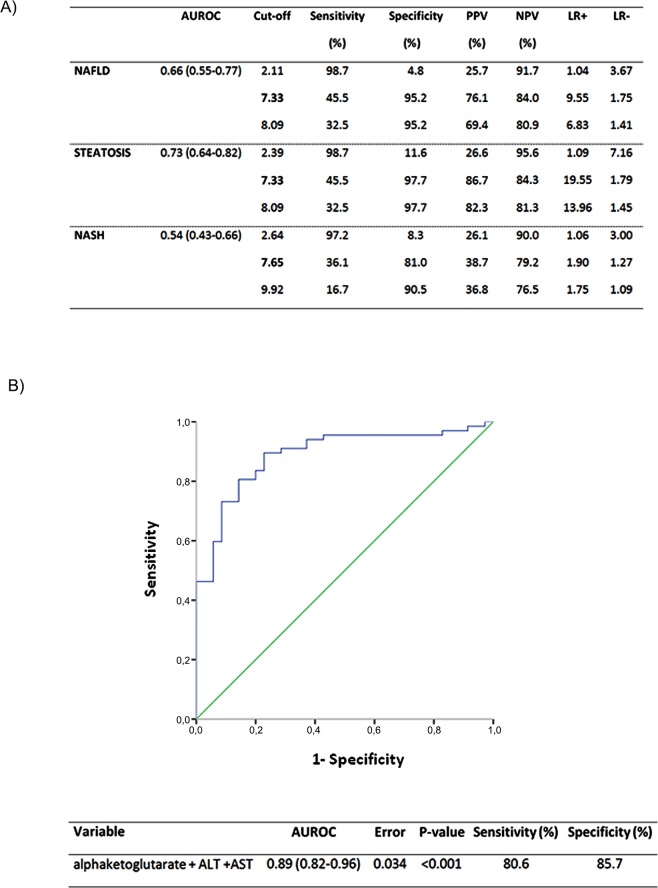
Serum alpha-ketoglutarate as a biomarker.(A) Accuracy of alpha-ketoglutarate biomarker in population studied. Represent the performance for discriminating NAFLD, steatosis and NASH from non- diseased patients. The three values of optimum cutting were selected based on obtaining a first cutoff of high sensitivity (>90%), a second cutoff that included the best combination of sensitivity and specificity according to the Youden index and a third, which prioritized specificity (>90%) (B) Evaluation of a multimetabolite model as biomarkers of NAFLD by the receiver operator characteristic (AUROC) curves. AUROC, area under the curve of receiver operating characteristics; ALT, alanine aminotransferase; AST, aspartate aminotransferase; LR+, positive likelihood ratio; LR-, negative likelihood ratio; NAFLD, non-alcoholic fatty liver disease; NASH, non-alcoholic steatohepatitis; NPV, negative prespective value; PPV, positive prespective value.